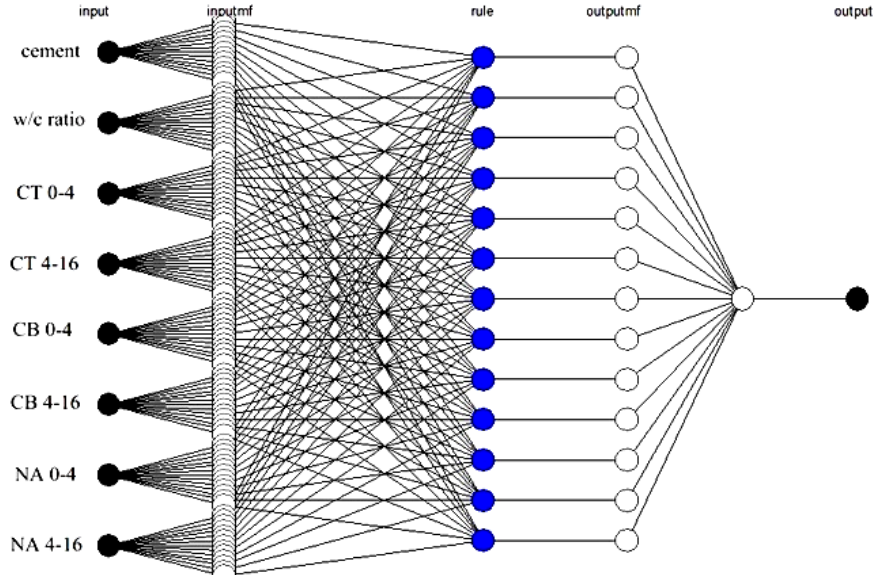
Fig. 5. Structure of ANFIS Model in Matlab